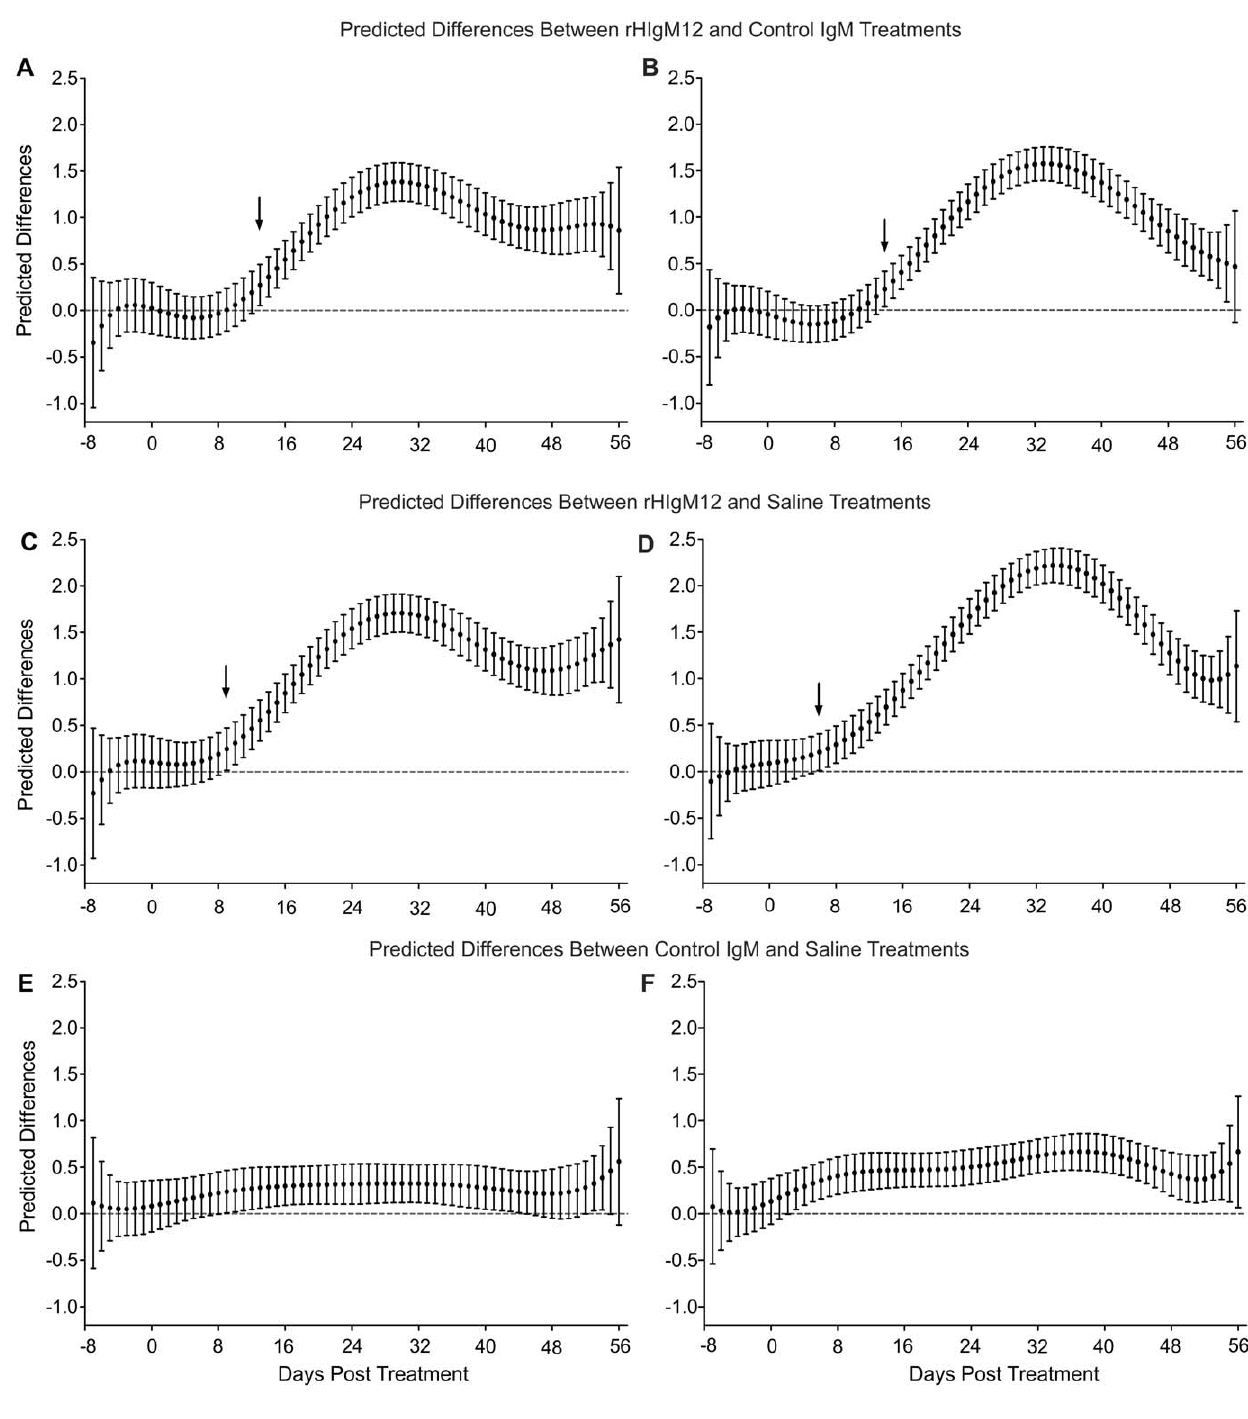
Figure 5. Comparison of three treatments at 45dpi by using predicted model values . Statistical analysis was performed for each day before and after the treatment. A, C) Horizontal nocturnal activity of rHIgM12-treated mice as compared to control IgM- and saline-treated mice significantly diverged on day 13 (p=0.015) and day 9 (p=0.036) post-treatment, respectively. B, D) Vertical (rearing) activity of rHIgM12-treated mice diverged/improved on day 14 (p=0.019) and day 6 (p=0.037) post-treatment, respectively. E, F) Comparisons of control IgM- vs. saline-treated mice did not reveal major biological changes neither for horizontal (E) nor for vertical (F) activity. Black arrows denote days with onset of significant improvement. The pointwise 95% confidence bands are given for each